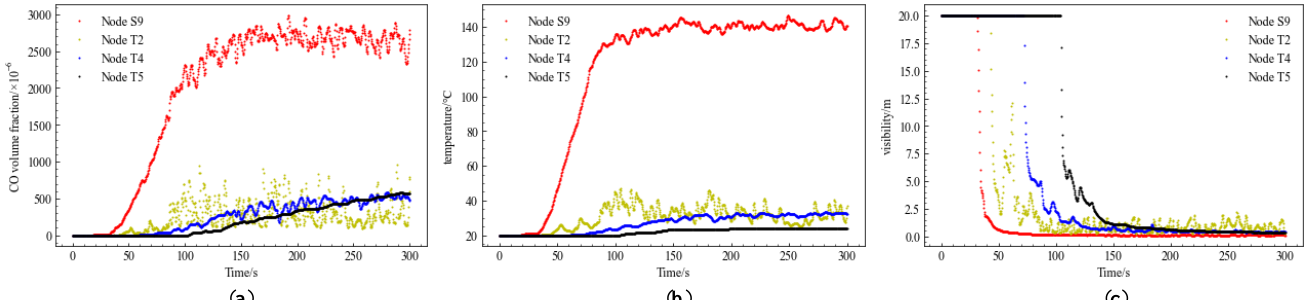
Figure 7. ( a ) CO volume fraction changing with time; ( b ) temperature changing with time; ( c ) visibility changing with